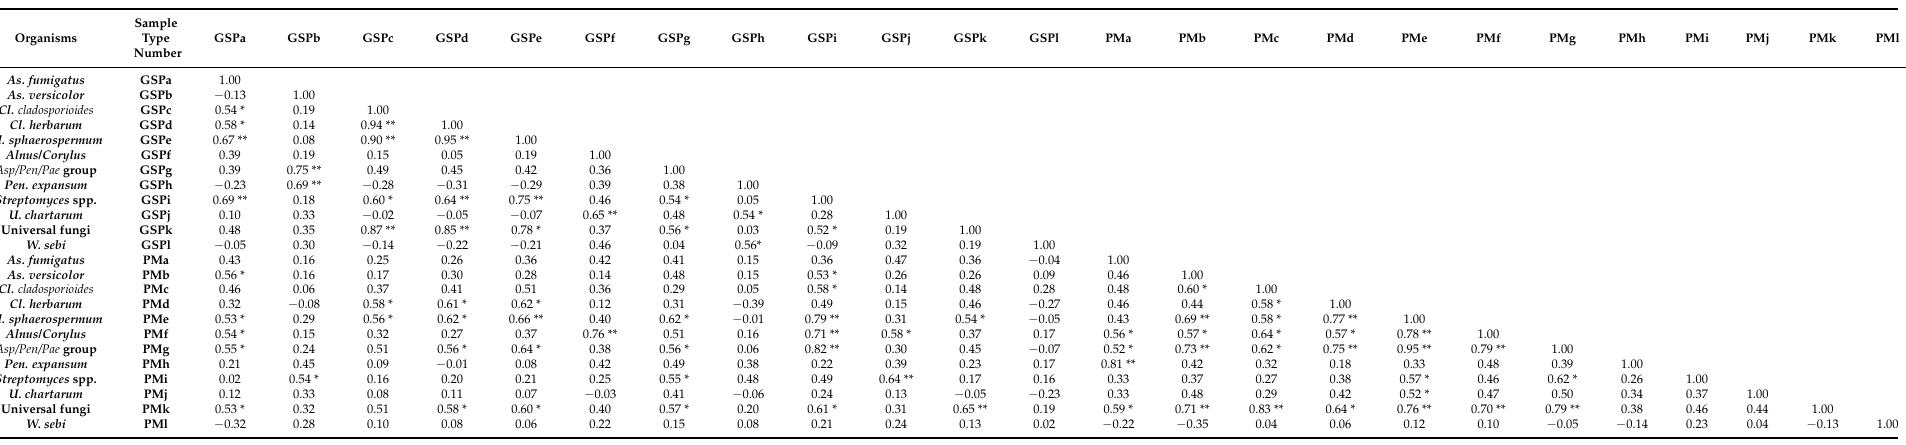
Table A2. Correlation coefficients (r) between concentrations of fungi and pollen in PM 1 and GSP samples as measured using Pearson’s correlation